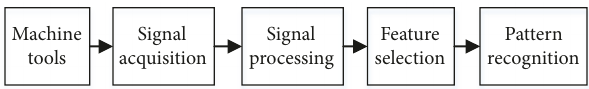
Figure 1: The framework of the tool monitoring